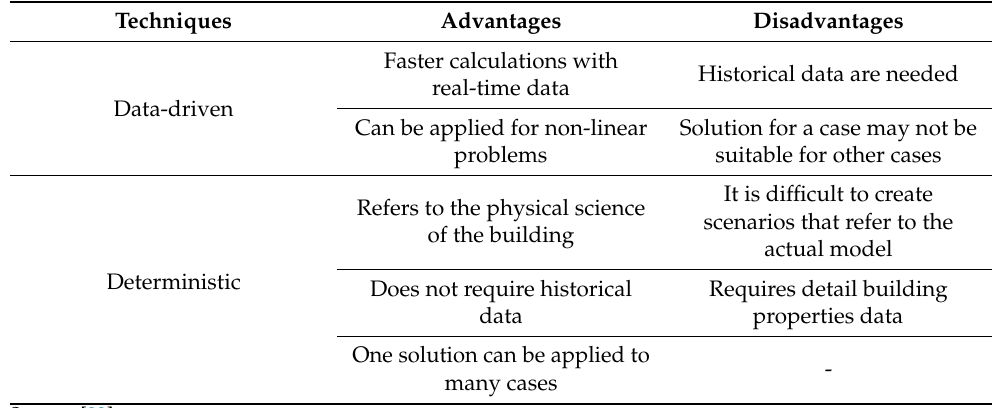
Table 1. The Advantages and Disadvantages of Data-Driven and Deterministic Technique. Techniques Advantages Disadvantages